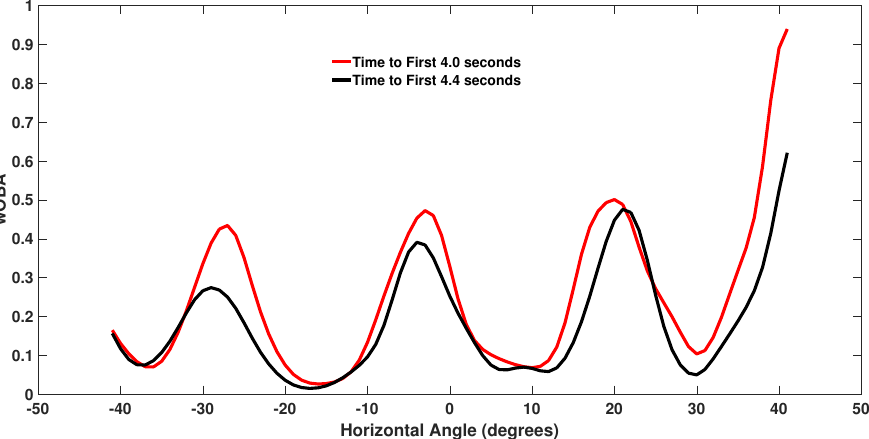
Figure 7. Weighted on base average (wOBA) for right-handed batter (RHB) batted balls with a speed s of 87 miles per hour and a vertical angle v of − 9 ◦ for two time to first ( r )